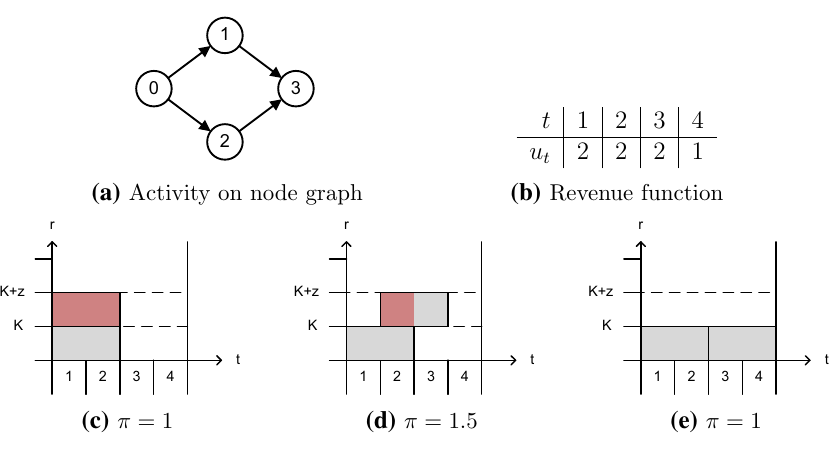
Fig. 6 Example of optimal schedule being outside of